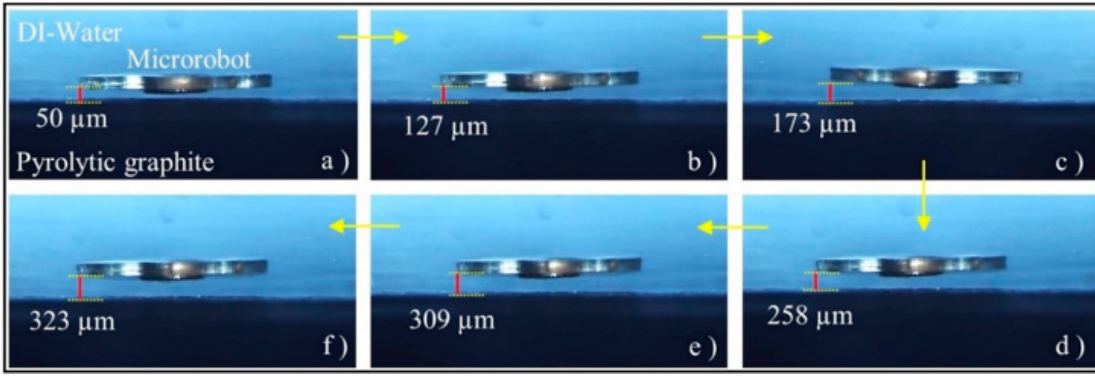
Figure 10. The experimental results show the micro-UFO with different levitation height depending on the distance between “Lifter Magnet” and the “Pyrolytic Graphite (PG)”. The experiment was recorded by acquiring the position data with the laser distance sensor in each movement step. The micro-UFO has been shown to operate at a maximum stabilization level of 333.8 µm in the current system. In figure, the micro robot is shown at various levitation heights based on lifter-magnet position relative to PG; ( a ) 50 µm, ( b ) 127 µm, ( c ) 173 µm, ( d ) 258 µm, ( e ) 309 µm and ( f ) 323 µm.